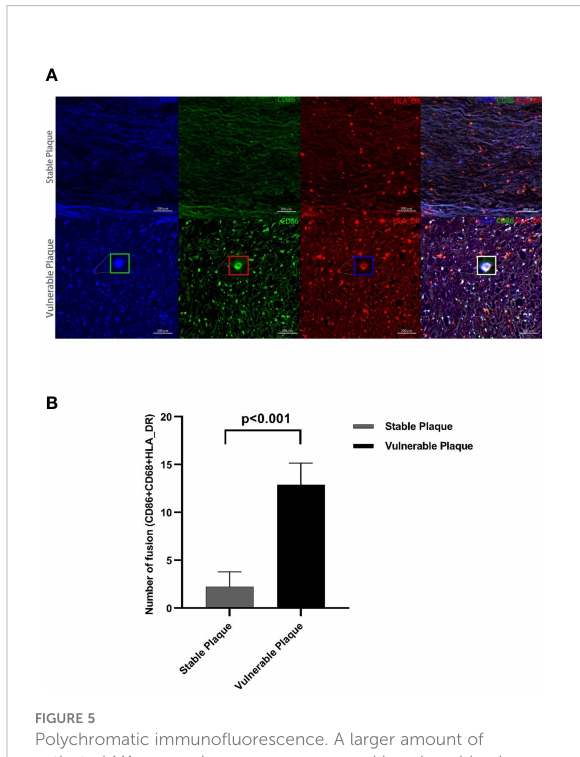
FIGURE 5 Polychromatic immuno fl uorescence. A larger amount of activated M1 macrophages were expressed in vulnerable plaques than in stable plaques. Typical multicolor immuno fl uorescence images of stable and vulnerable plaques are shown in Figure (A) . Statistical difference in CD68+CD80+HLA_DR+ particles between two groups were shown in Figure (B)